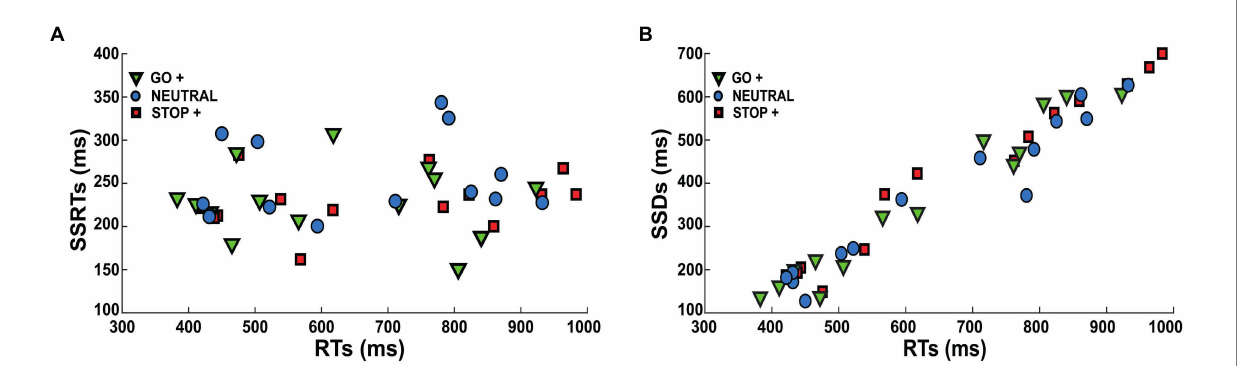
possible between 32% (MAP = 0.55, 96% HPDI: [0.28 0.79], 50% HPDI: [0.46 0.64], Figure 7A) and 39% of the tested subjects (MAP = 0.62, 96% HPDI [0.35 0.85], 50% HPDI: [0.46 0.64], Figures 7C,D).